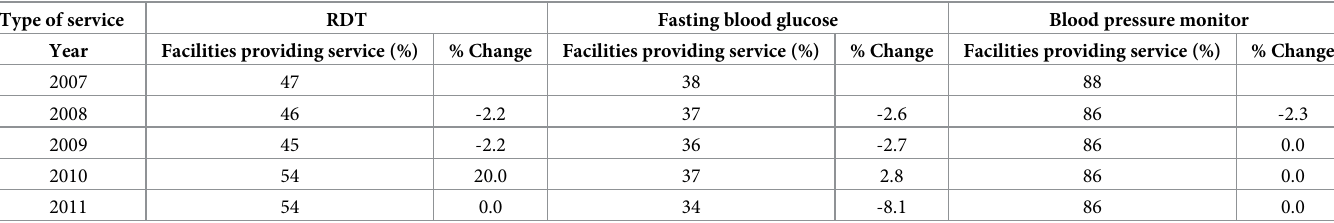
Table 2. Trends in RDT, fasting blood glucose and blood pressure diagnosis services at health facilities in Ghana, 2007–2011. Type of